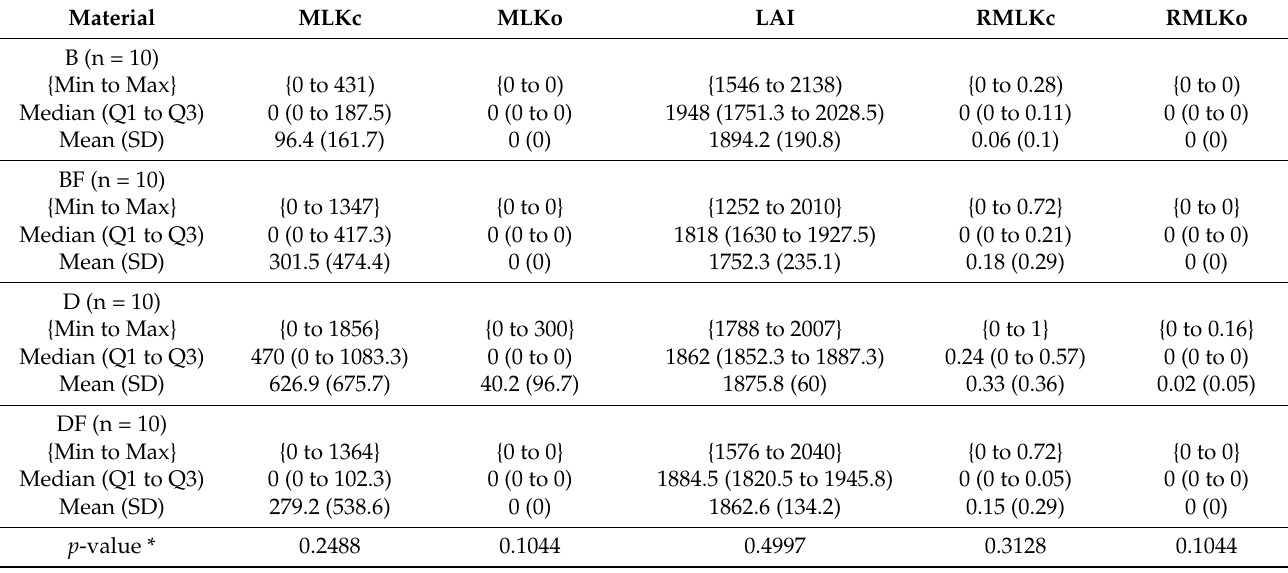
Table 2. Data summary collected for microleakage test based on material type: enamel-located restorations.